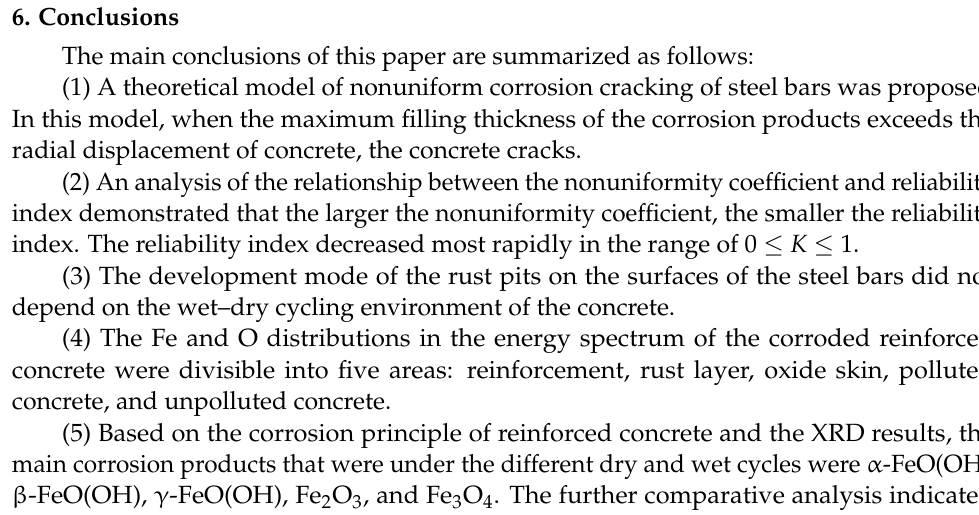
Figure 16. Transformation process of the main oxidation products of